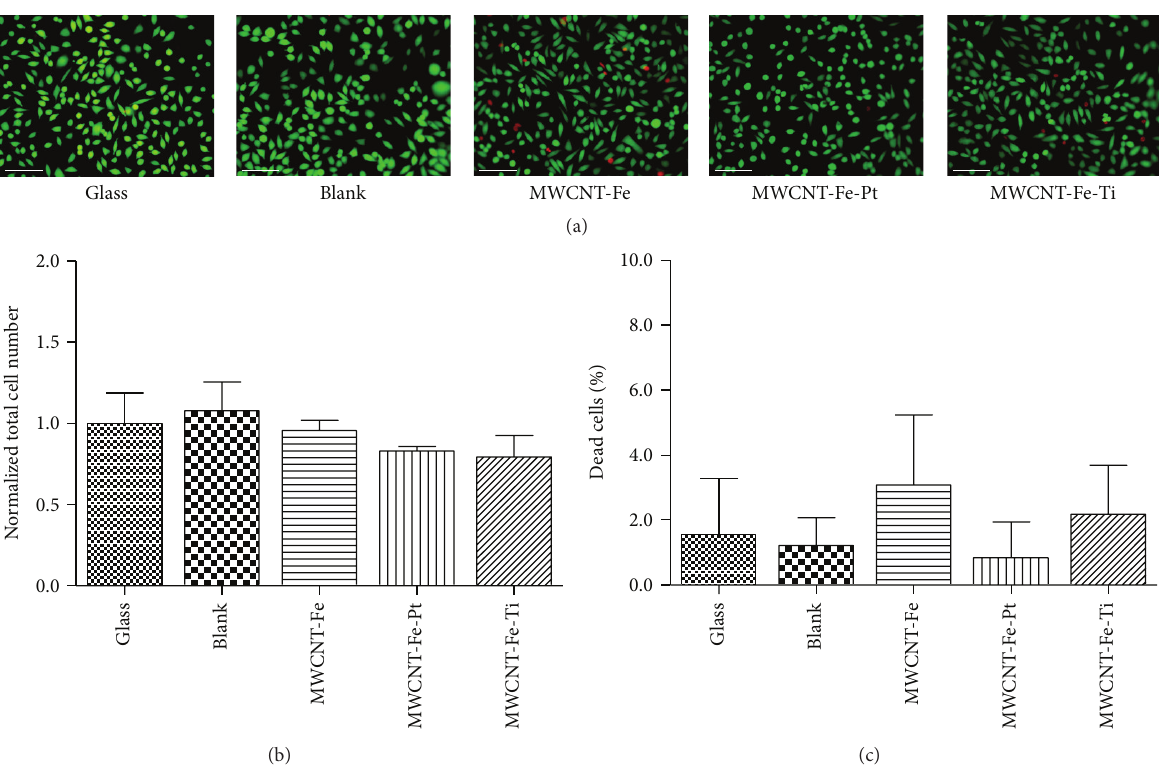
Figure 3: Effects of direct contact on viability of L-929 cells. Cells were plated on a glass substrate and on the blank, MWCNT-Fe, MWCNT- Fe-Pt, and MWCNT-Fe-Ti wafer slices ( 𝑛 = 1 experiment), stained using FDA/PI, and counted 72 hours after seeding. (a) Fluorescence microscopy allowed for differentiation between vital (green) and dead (red) cells (scale bar: 100 𝜇 m). (b) The total cell numbers were normalized to the respective glass control. (c) The quantity of dead cells is shown as a percentage of the corresponding total cell number. For each substrate, 6 randomly selected microscopic fields were analyzed. Data are represented as mean ± SD. They were compared to the glass control and analyzed using unpaired two-tailed 𝑡 test, showing no significant